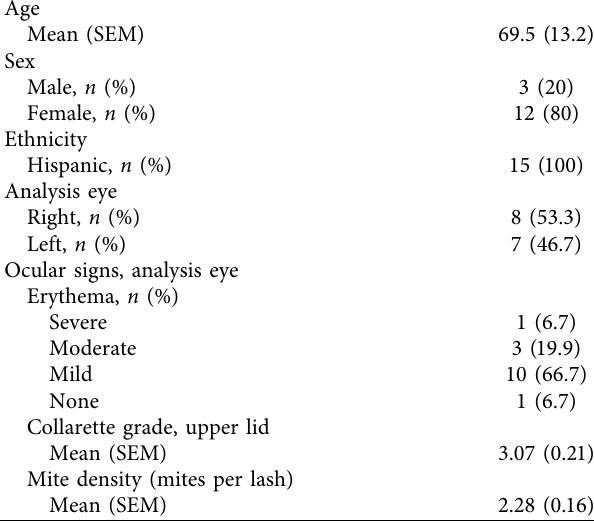
Table 1: Demographics and baseline